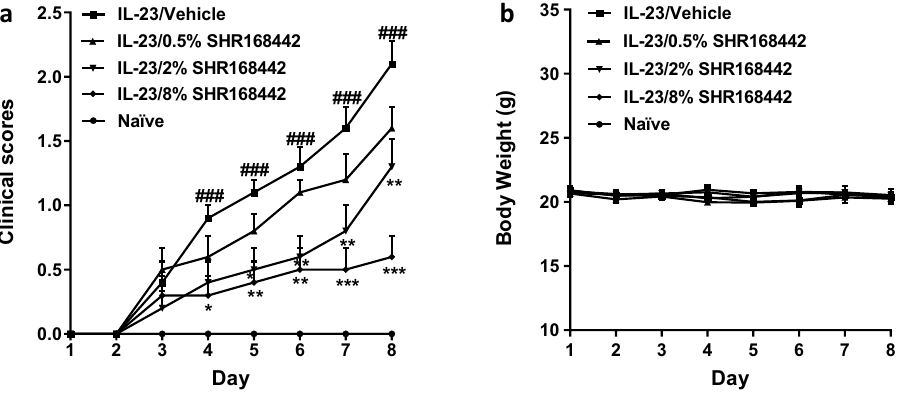
Figure 4. Effect of the treatment of SHR168442 in Vaseline in IL-23-induced psoriasis-like skin inflammation mice. ( a ) Clinical scores of the dorsal skin were measured daily on a scale of 0 to 4. Symbols indicated mean ± SEM of 10 mice per group. Vehicle = Vaseline. Data were analyzed by one-way ANOVA, ### p < 0.001 versus Naïve; * p < 0.05, ** p < 0.01, *** p < 0.001 versus vehicle. ( b ) Body weights of mice were measured daily.